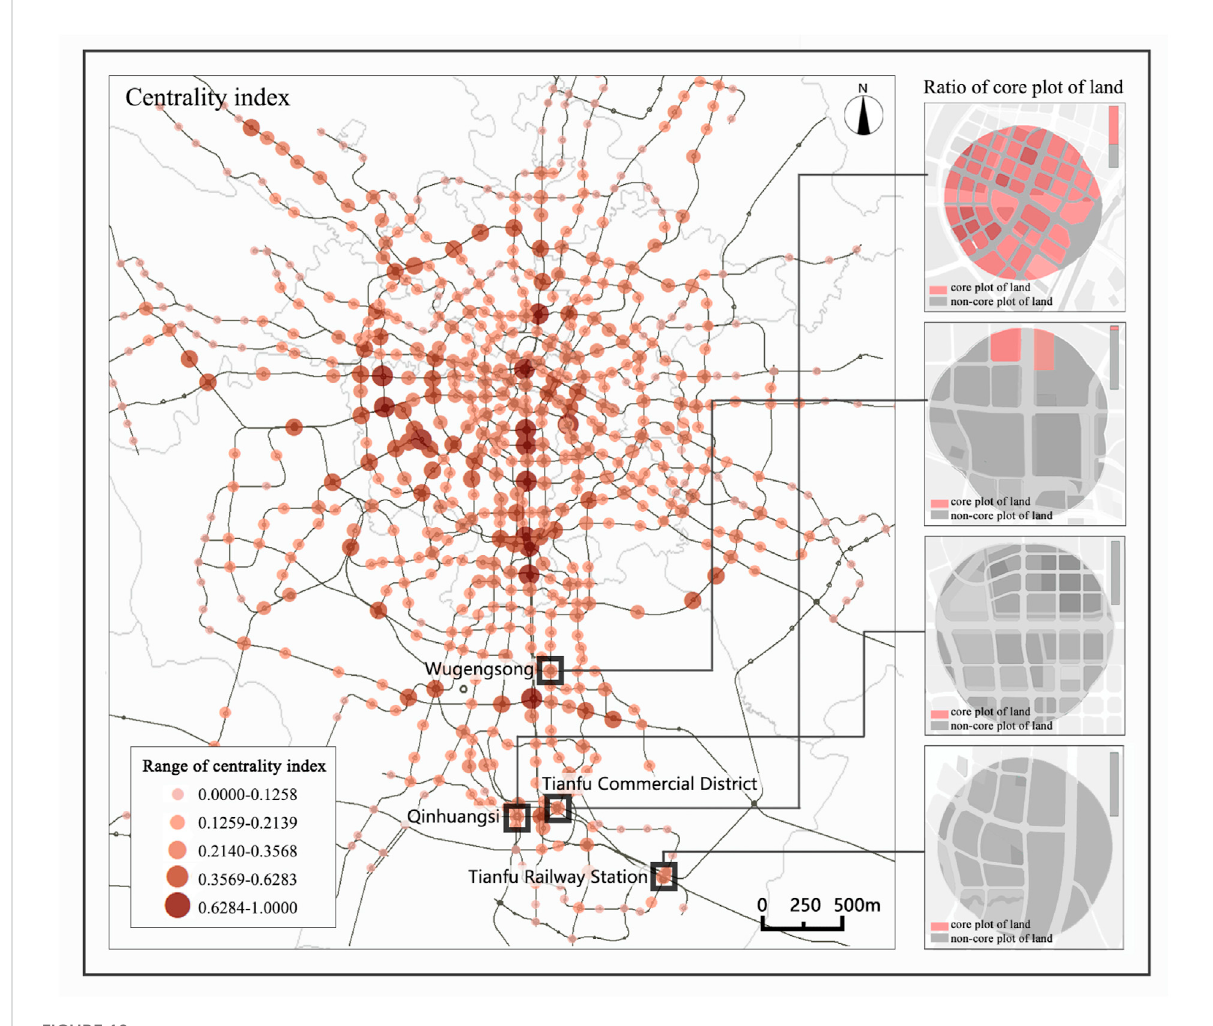
FIGURE 10 Centrality index of all metro stations in Chengdu City and core plot of land of four typical